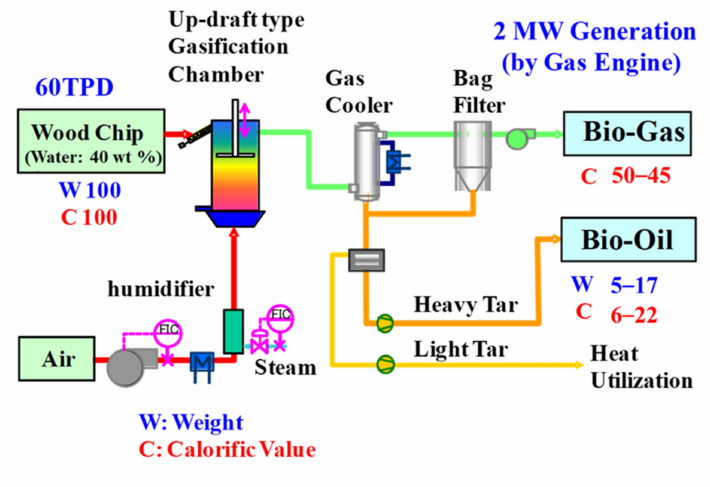
Figure 4. Summary of a gasification and bio-oil co-production process using an updraft reactor.